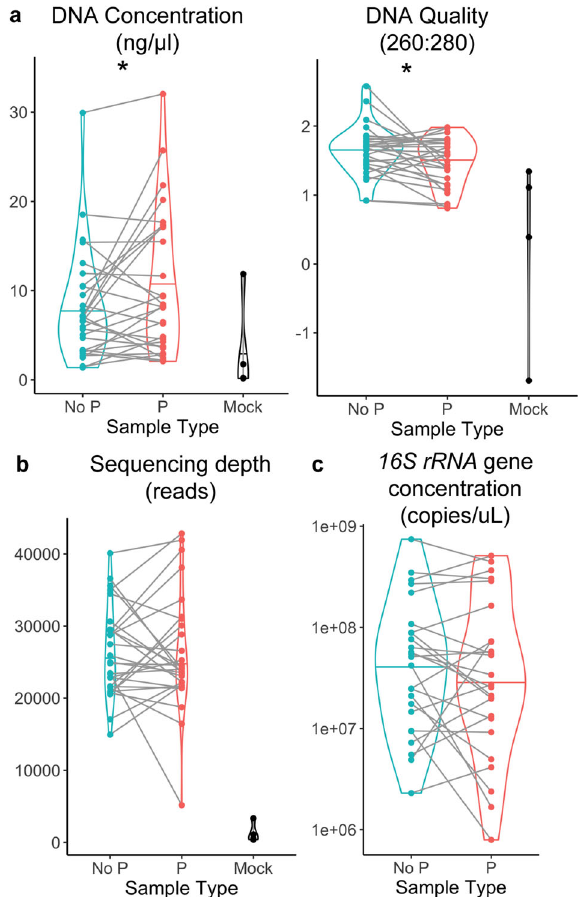
Fig. 2 DNA extraction and sequencing, according to saliva collection method. The fi gure compares samples in preservative (P), or not (No P), or mock samples. a DNA quantity and quality post- extraction; * p < 0.05, linear mixed effect model. b Sequencing depth after processing in QIIME2; not signi fi cant, linear mixed effect model. c 16S rRNA gene concentration in the two sample types; not signi fi cant, linear mixed effect model. Center line on plots indicates